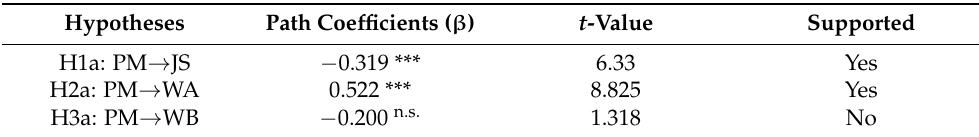
Figure 2. Path coefficients and R-squares of the inner model. Table 5. Summary of inner model results.